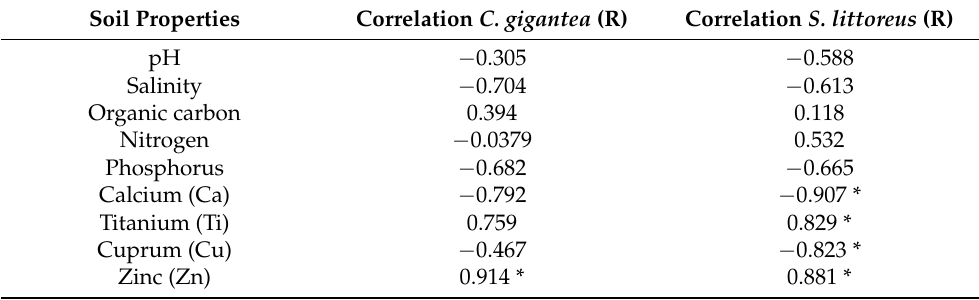
Table 2. Correlation Analysis Between Bacterial Diversity and Soil Properties.